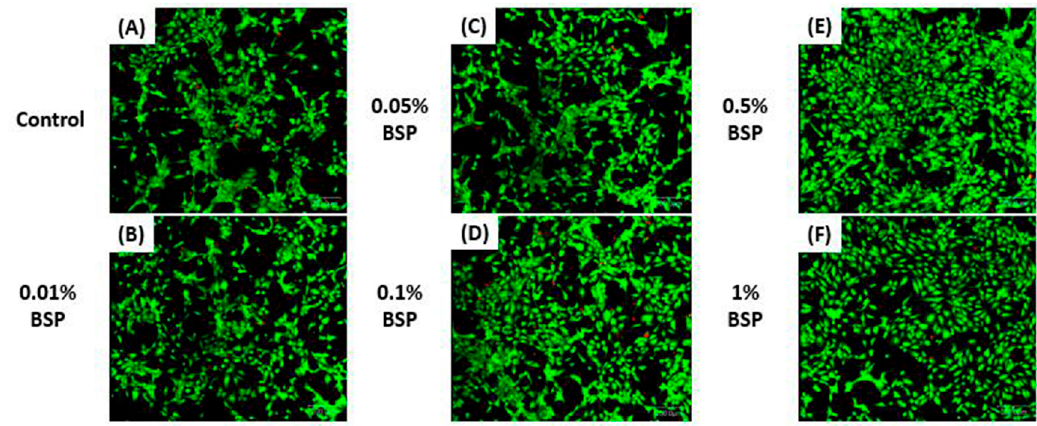
Figure 4. Cell viability of human corneal epithelium cells (HCECs) assessed by live and dead staining ( A ) Control group, HCEC treated with ( B ) 0.01% BSP; ( C ) 0.05% BSP; ( D ) 0.1% BSP; (E) 0.5% BSP; (F) 1% BSP; scale bar: 200 μ m.